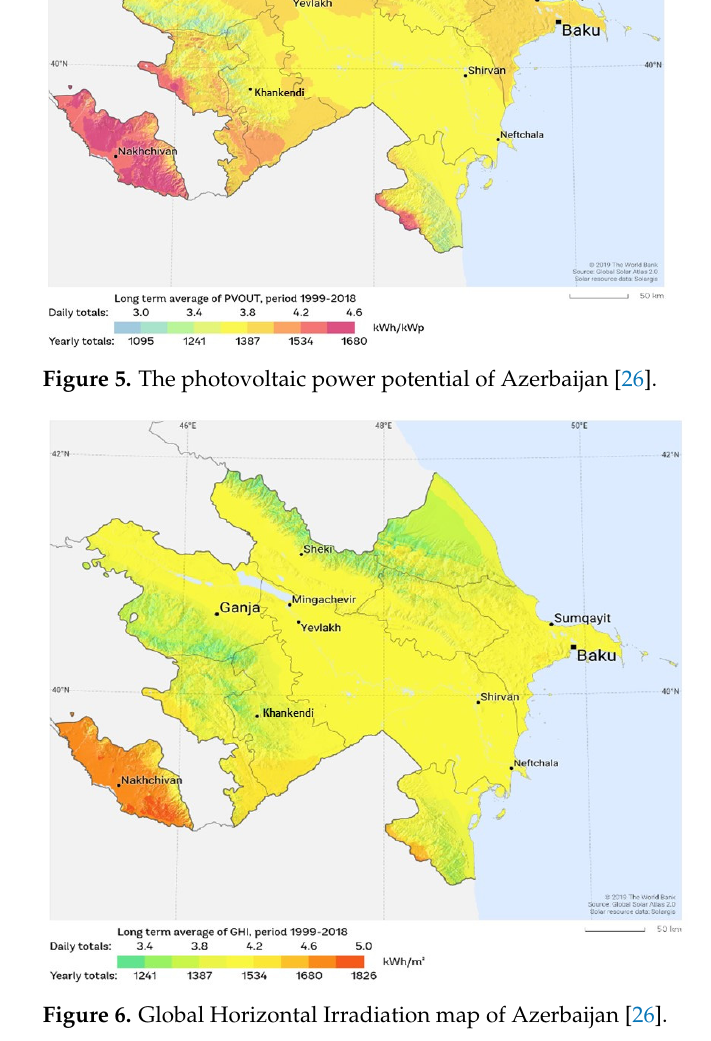
Figure 7. Direct Normal Irradiation map of Azerbaijan [26]. Table 9. Prospective solar plant projects presented by the Ministry of Energy of Azerbaijan [27]. Project Name and Location